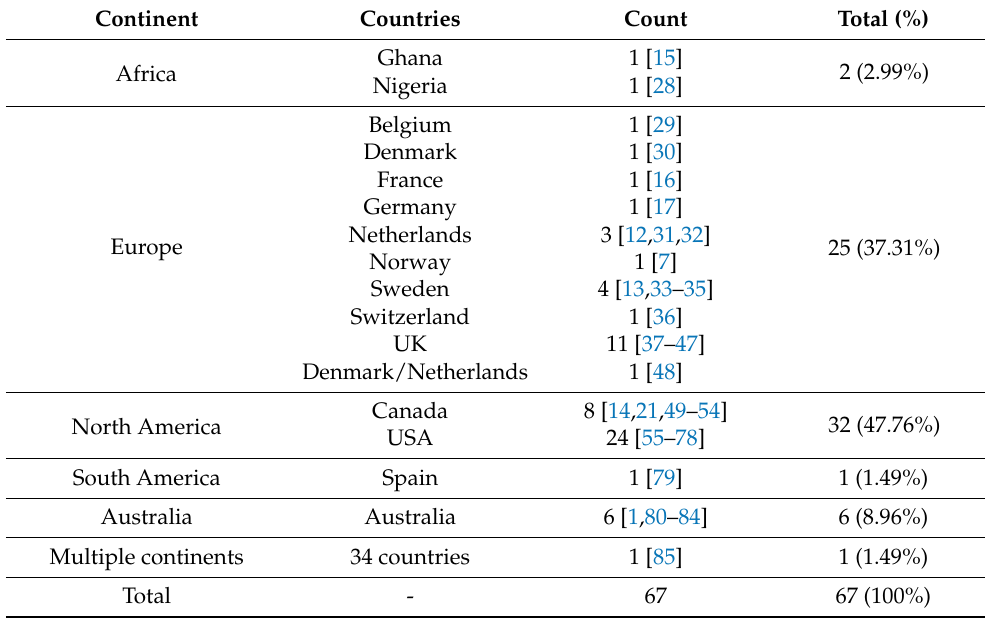
Table 1. Summary of the study countries and